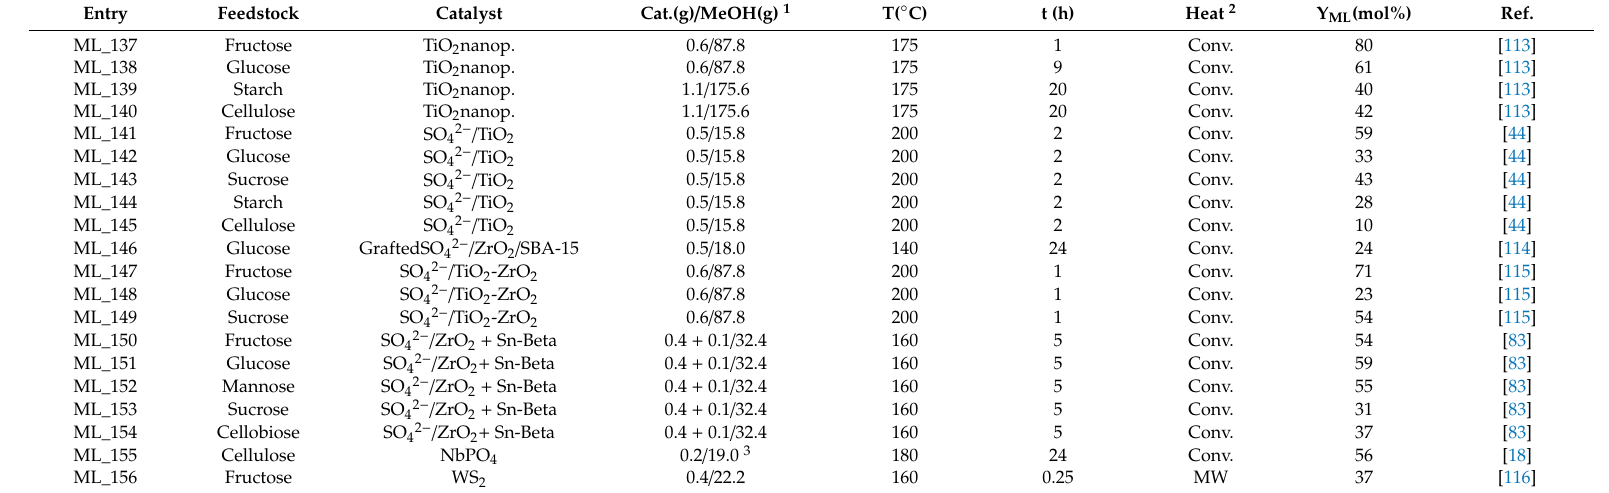
Table 6. Modified metal oxides and tungsten disulfide catalysts for the ML production from C6 model